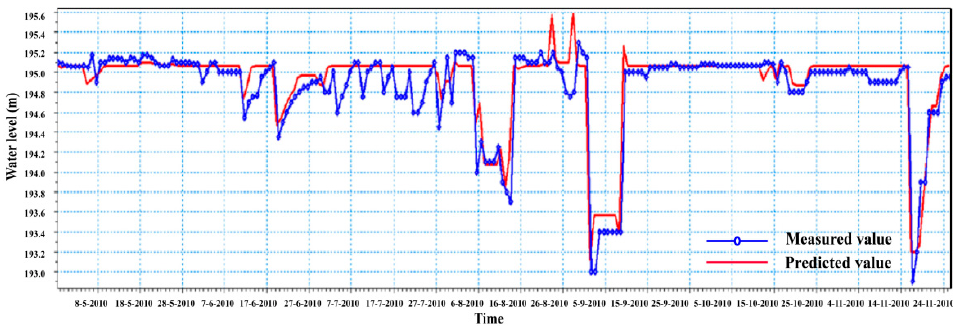
Figure 3. Simulated result of the water level at Cross Section B.